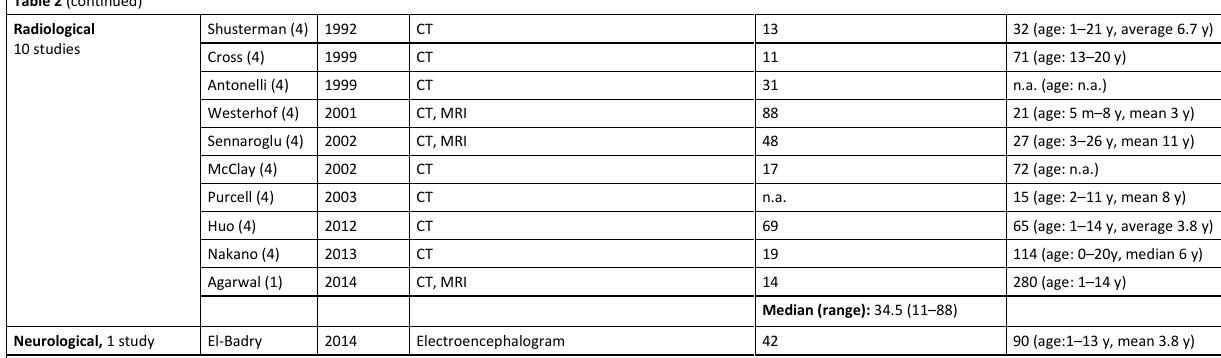
Neurological, 1 study